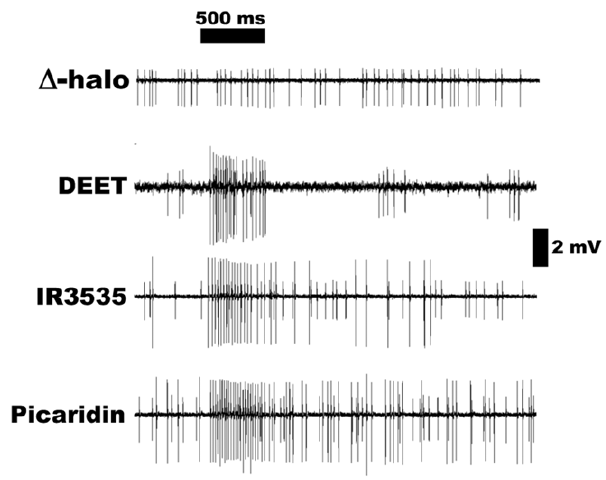
Figure 8. Action potentials recorded from ab3 sensilla. D halo flies showed spontaneous activity of neuron B, but not A, thus showing the ab3A is indeed ‘‘empty.’’ Lower traces were excitatory responses induced by DEET, IR3535, and picaridin and recorded from ab3 sensilla of Or42-expressing flies (w; D halo; UAS-DmOr42a/Or22a-GAL4).